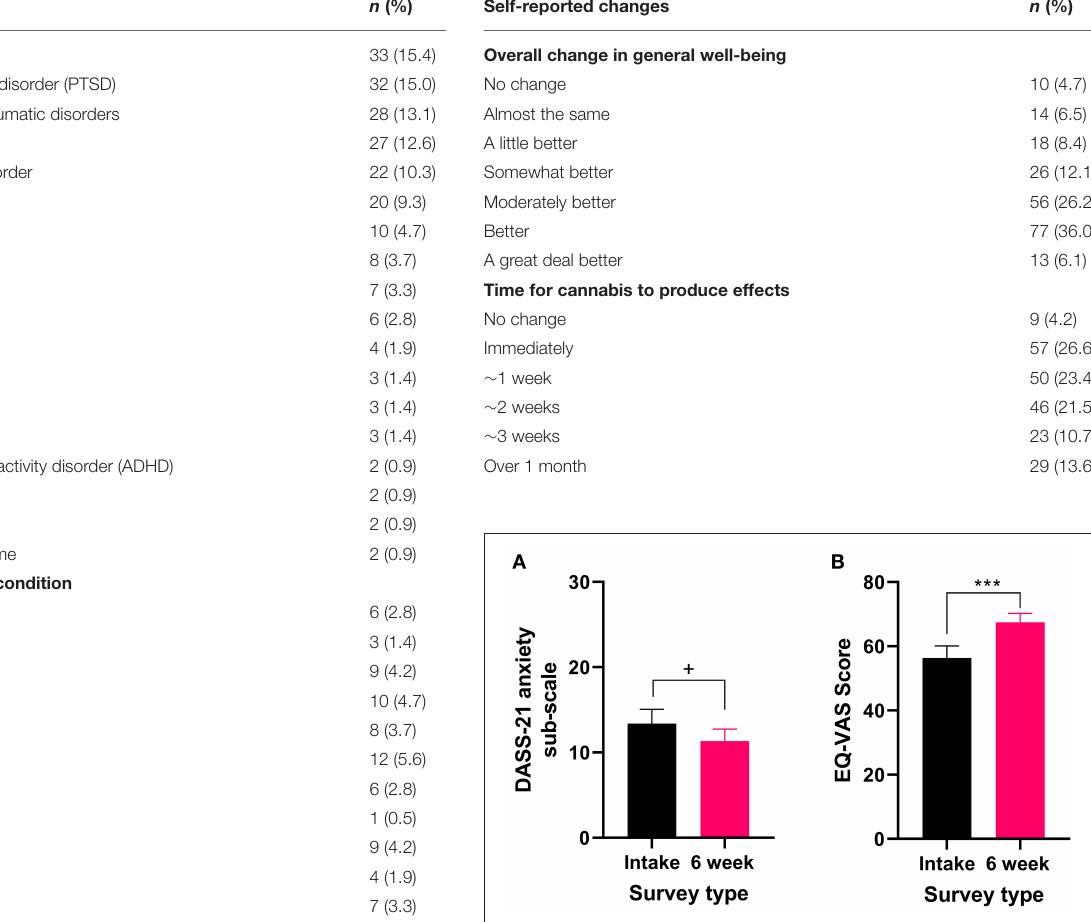
TABLE 4 | The number (and percentages) of medical cannabis patients who self-reported each medical condition. Medical condition